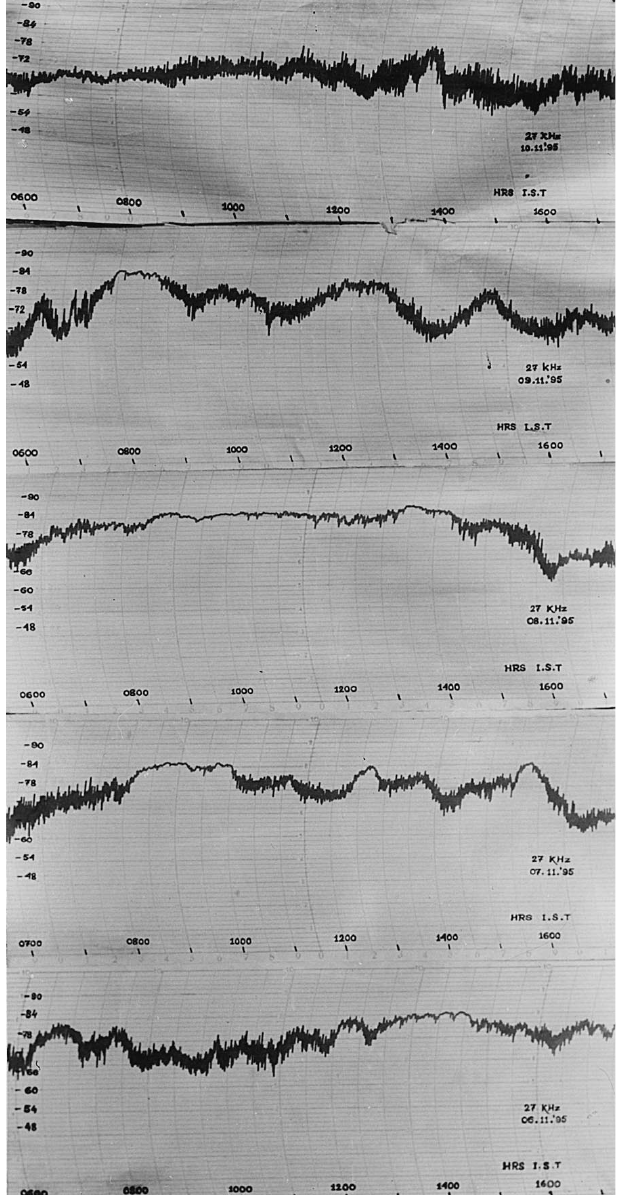
Fig. 1. Photograph of typical atmospheric records during heavy rainy days